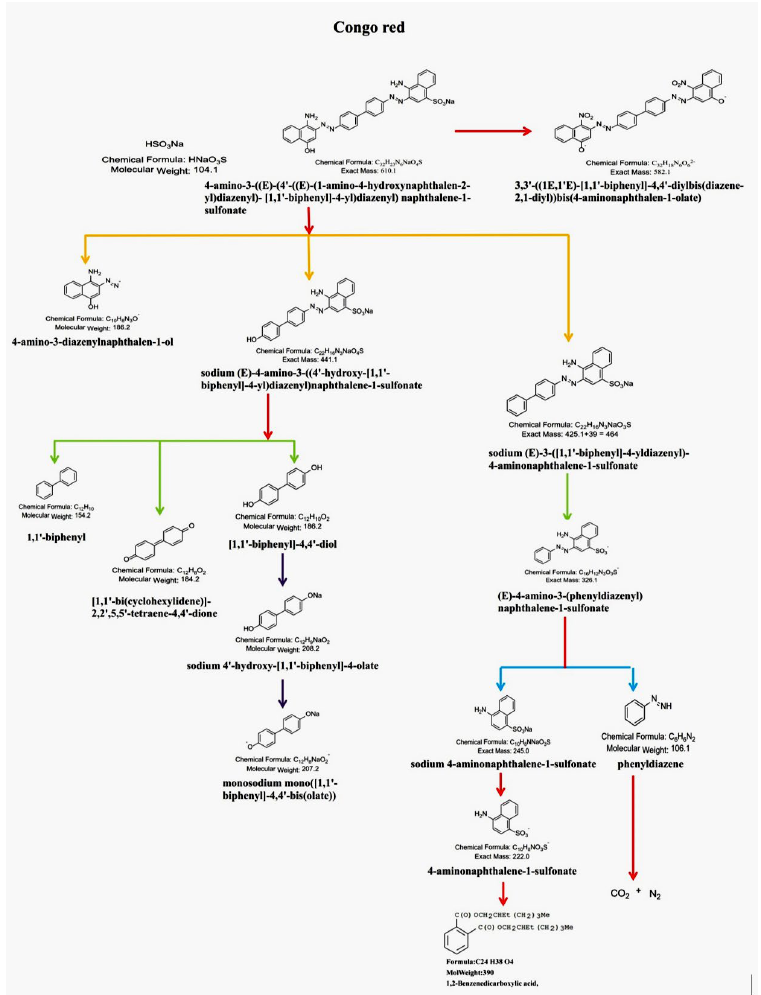
Fig. 8. Proposed pathway of Congo red-21 degradation by Laccase mediated